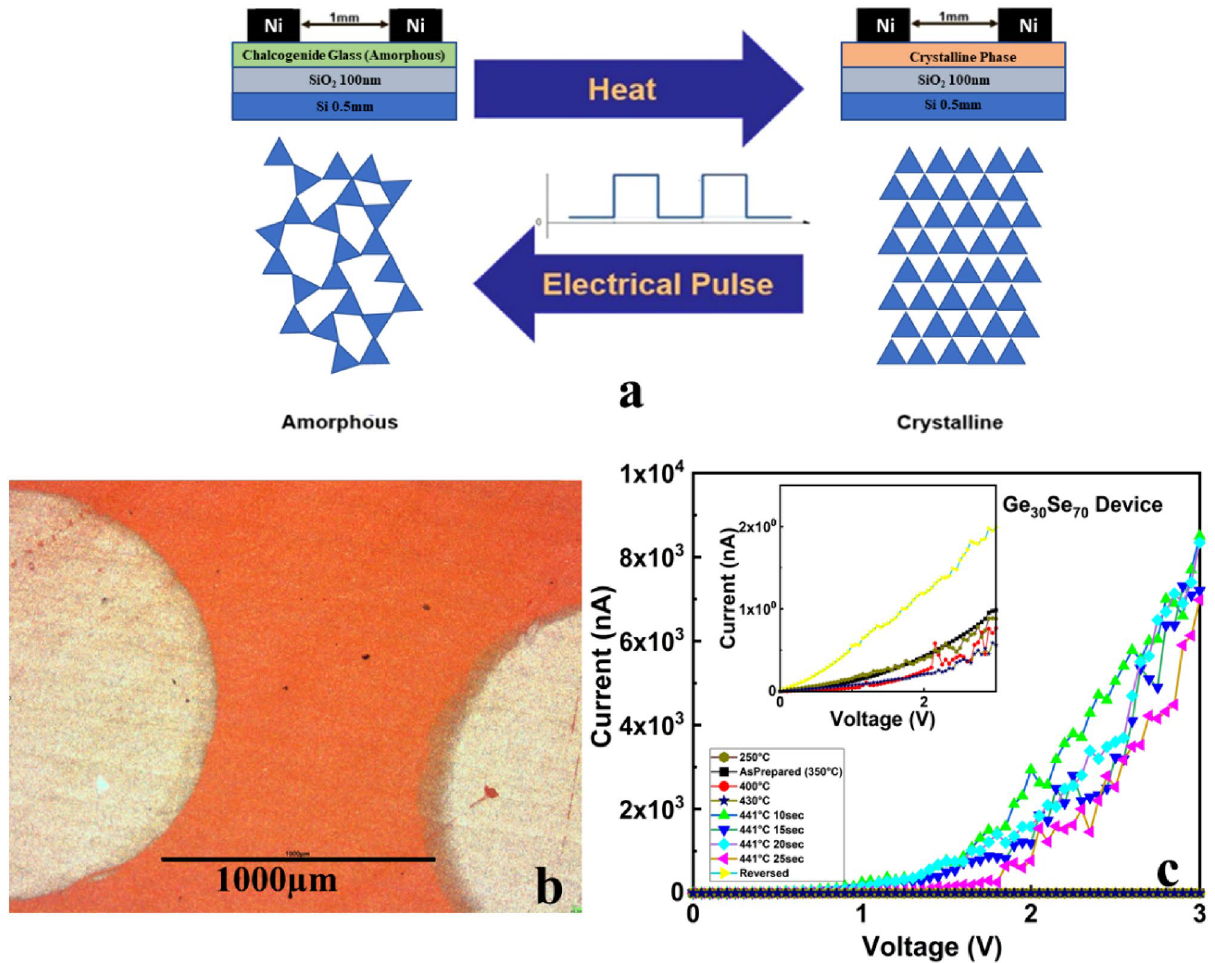
Figure 8. Schematic of a printed device with ( a ) its operational mode, ( b ) optical microscope photo of the device, and ( c ) IV characteristic of the